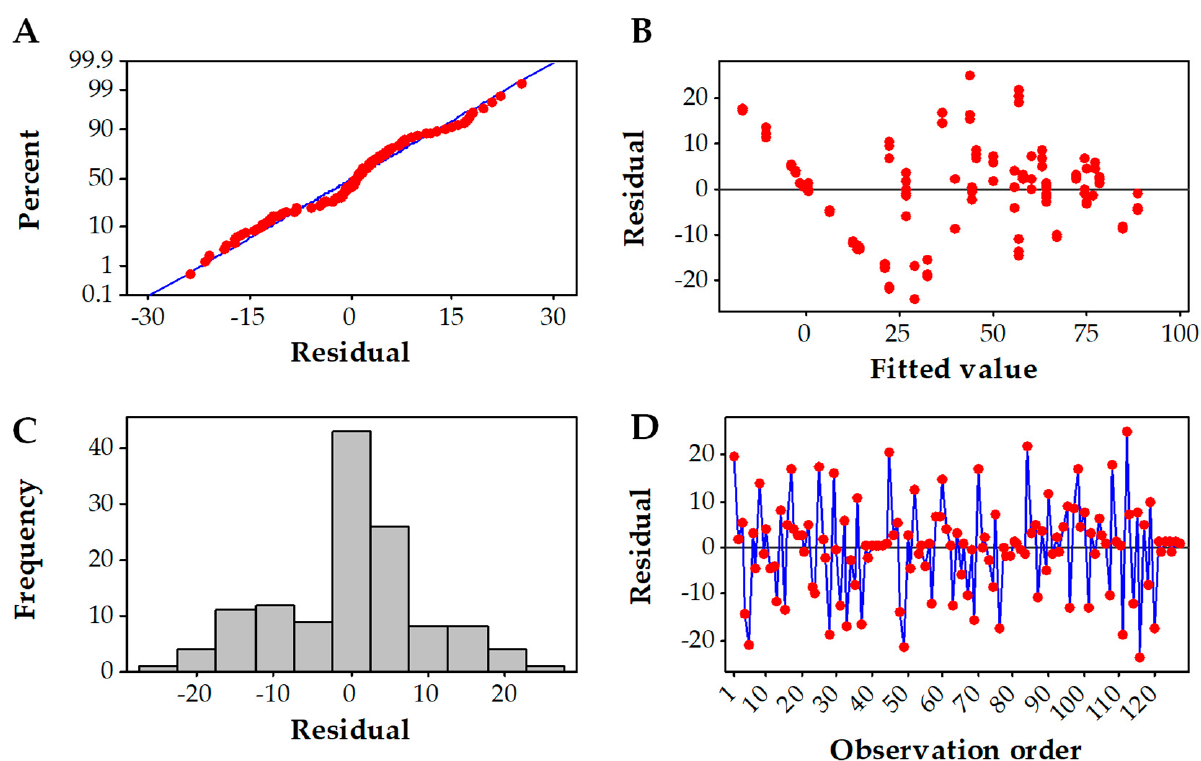
Figure 2. Residual plots for RB5 decolorization using the Box–Behnken design. ( A ) Normal probability plot. ( B ) Versus fits. ( C ) Histogram. ( D ) Versus order. Iso-responses plots (contour curves) were analyzed to visualize the interaction between factors. Figure 3A showing RB5 decolorization computed as a function of dye concentration and HBT concentration (all other factors were held at center level) indicates that the increase in dye concentration from 25 mg L − 1 (level − 1) to 125 mg L − 1 (level +1) decreased RB5 decolorization from 80% to 30%. Increasing HBT concentration to 2.5 mM (center of the experimental domain—level 0) improved RB5 decolorization compared to the condition with 0.5 mM of HBT. Contour plots for the laccase-like activity × temperature interaction (Figure 3B) showed that increasing both factors improved decolorization percentages from 20% to more than 70%. Contour plots for the laccase-like activity × pH